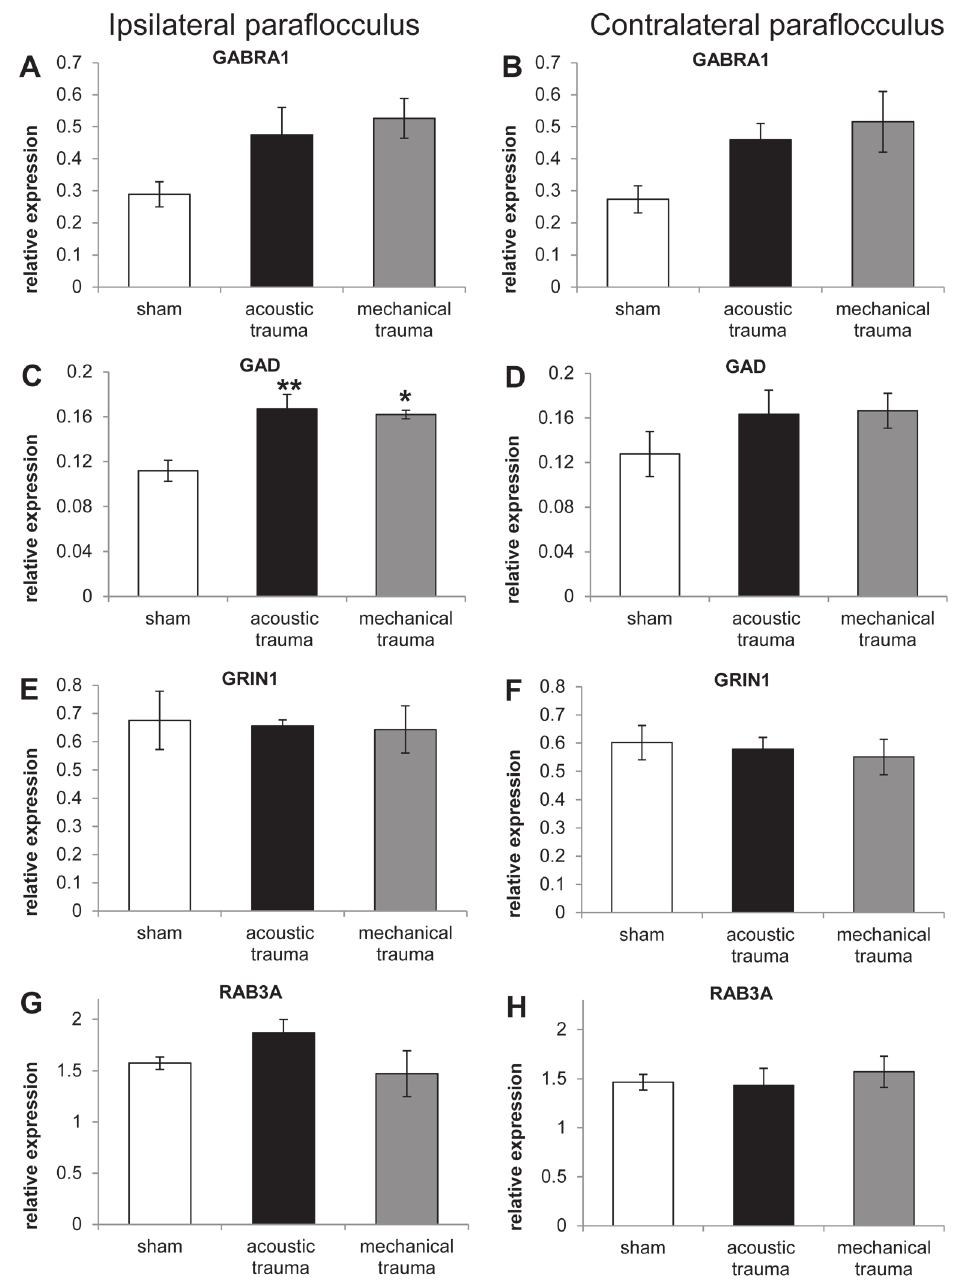
Figure 2. RT-PCR data from paraflocculus in animals subjected to sham, acoustic trauma and mechanical trauma. Changes in mRNA expression levels of 4 genes in the left (ipsilateral; A , C , E , G ) and right (contralateral; B , D , F , H ) paraflocculus in sham (white bars), acoustic trauma (black bars) and mechanical trauma animals (grey bars), after 2 weeks recovery, as shown by qRT-PCR. Gene abbreviations: GABR1: GABA-A receptor subunit alpha 1; GAD1: glutamate decarboxylase 1; GRIN1: glutamate receptor NMDA subunit 1; RAB3A: a member of RAB family of small GTPase. Values are mean ± SEM. Statistical analysis: * p <0.05, ** p <0.01. Asterisks indicate comparison with sham